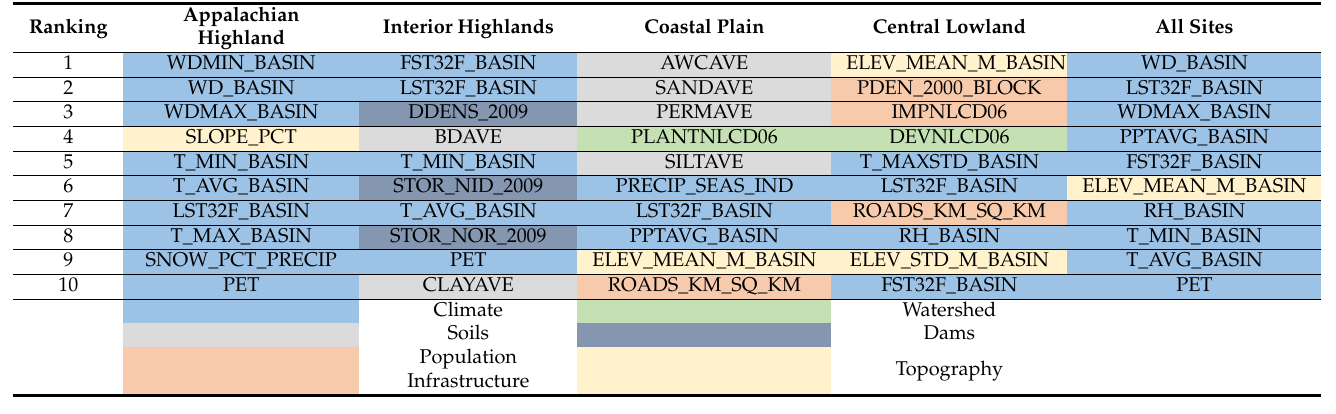
Table 2. Types of most important (ranking 1 to 10) predictor variables across different physiographic regions. Description of predictor variables is provided in Appendix A.